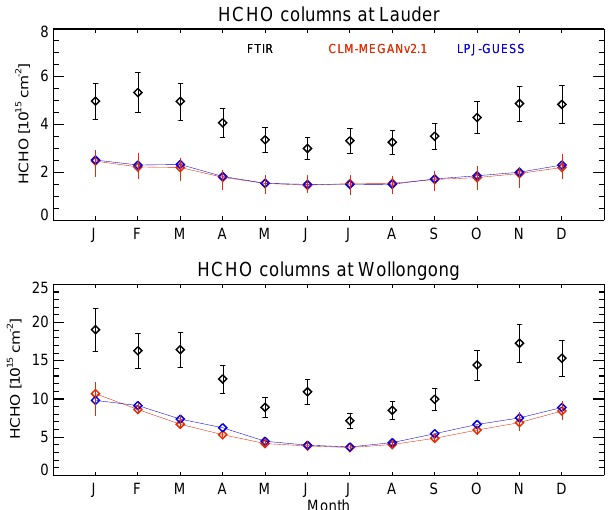
Figure 10. Observed (black symbols) FTIR multi-annual monthly- mean HCHO columns and corresponding multi-model mean from CLM-MEGANv2.1 (red) and LPJ-GUESS (blue) simulations. Mea- surement errors are shown by vertical bars (black). Model ranges from the CLM-MEGANv2.1 simulations are also given (coloured vertical